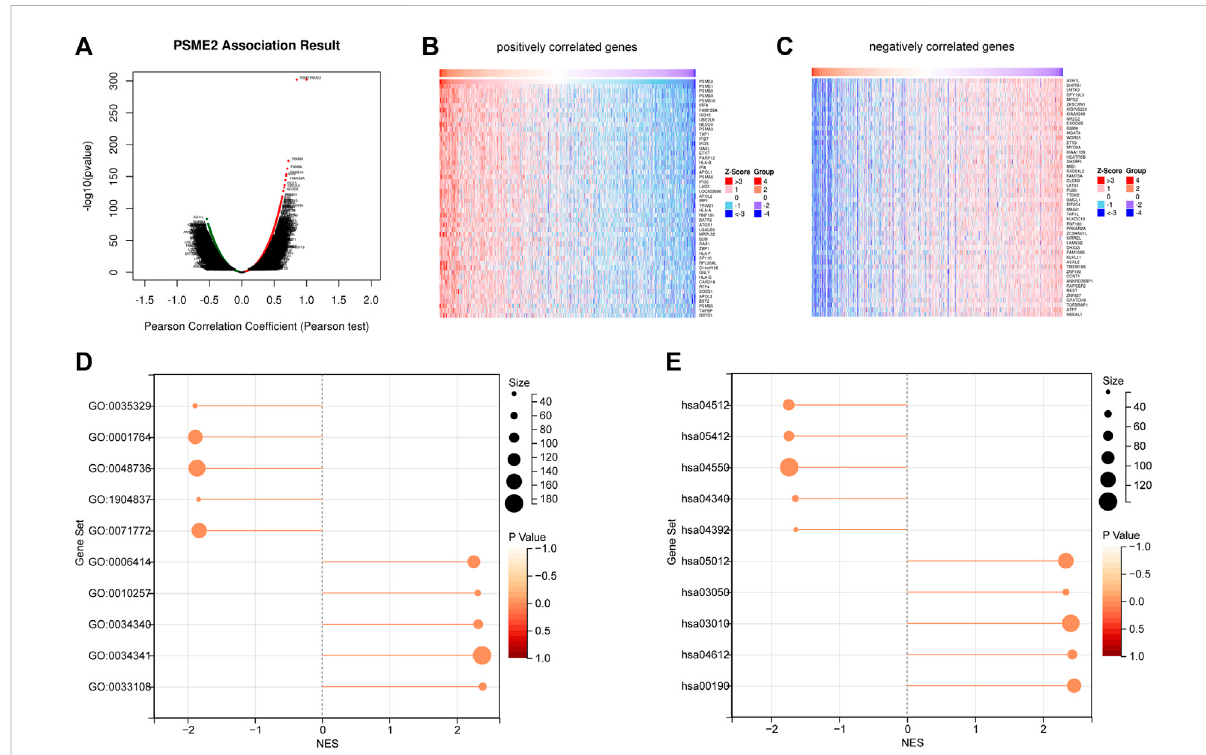
Screening ofPSME2-correlated genes and enrichmentanalysis (A) The global PSME2 highly associated genes identi fi edby Pearson test inBrCa (B) Heat maps showing top 50 genes positively associated with PSME2 in BrCa (C) Heat maps showing top 50 genes negatively associated with PMSE2 in BrCa. Data of A-C was obtained from the TCGA dataset (D) BP and (E) KEGG enrichment analyses of PSME2-related genes in